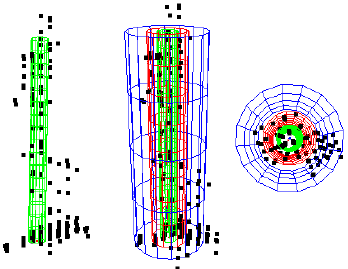
Figure 4: Cylindrical shape context around axis. Center: side view. Right: top view. Only single angular category